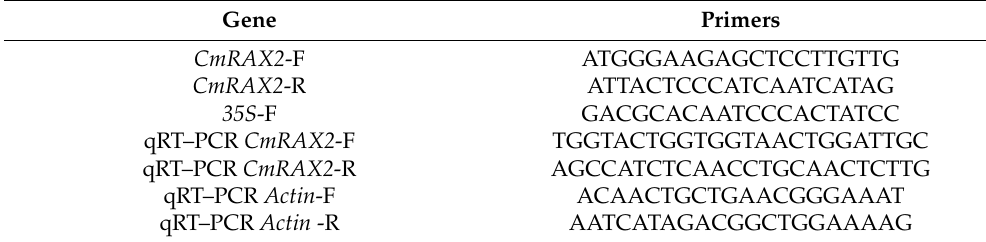
Table 1. Specific